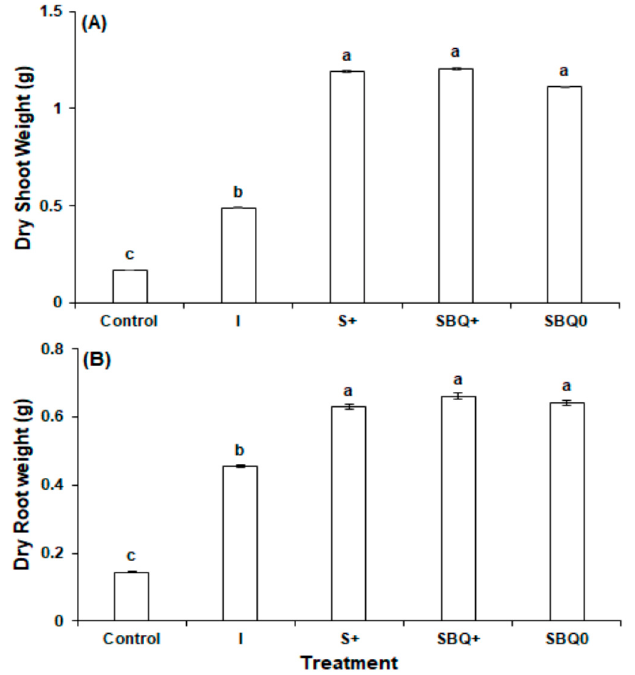
Figure 4. Dry weight of radish in experiment 2: ( A ) Shoot weight ( B ) root weight. All different letters are significant at p <